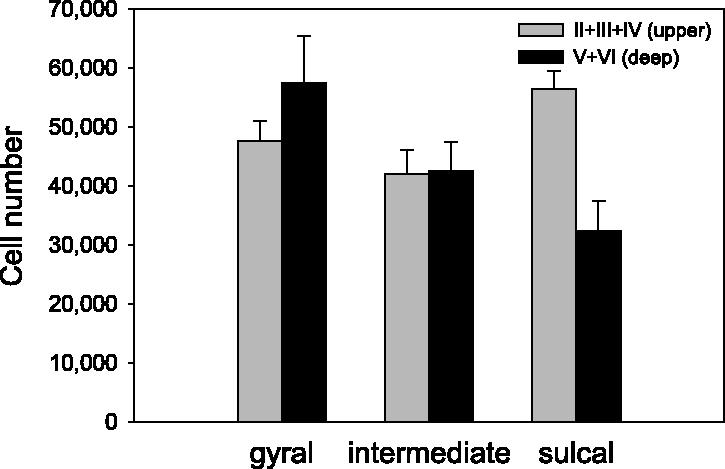
Effect of Cortical Folding on Neuron NumberNumber of neurons found below a unit of 1 mm2 surface area and extending to the variable width of the upper (II+III+IV) and deep (V+VI) layers of gyral, intermediate, and sulcal cortices. Layer I was excluded from the analyses because of its separate developmental path and paucity of neurons [31]. There were significantly fewer neurons in layers V+VI of intermediate areas than in gyral areas and in the deep layers of sulcal than intermediate areas (pairwise t tests, Bonferroni-adjusted, p < 0.05). Conversely, there were more neurons in the upper layers of sulcal areas than in intermediate or gyral areas.